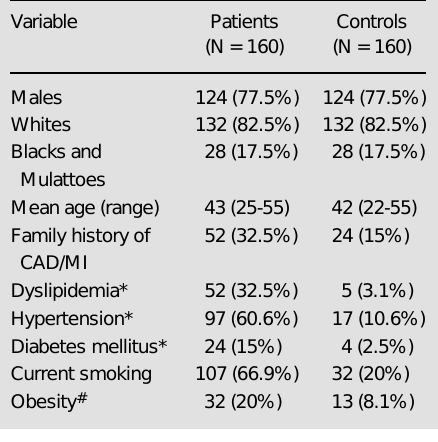
Table 1 - General characteristics of myocardial infarction (MI) survivors with angiographically demonstrated severe atherosclerosis and of con- trol subjects.